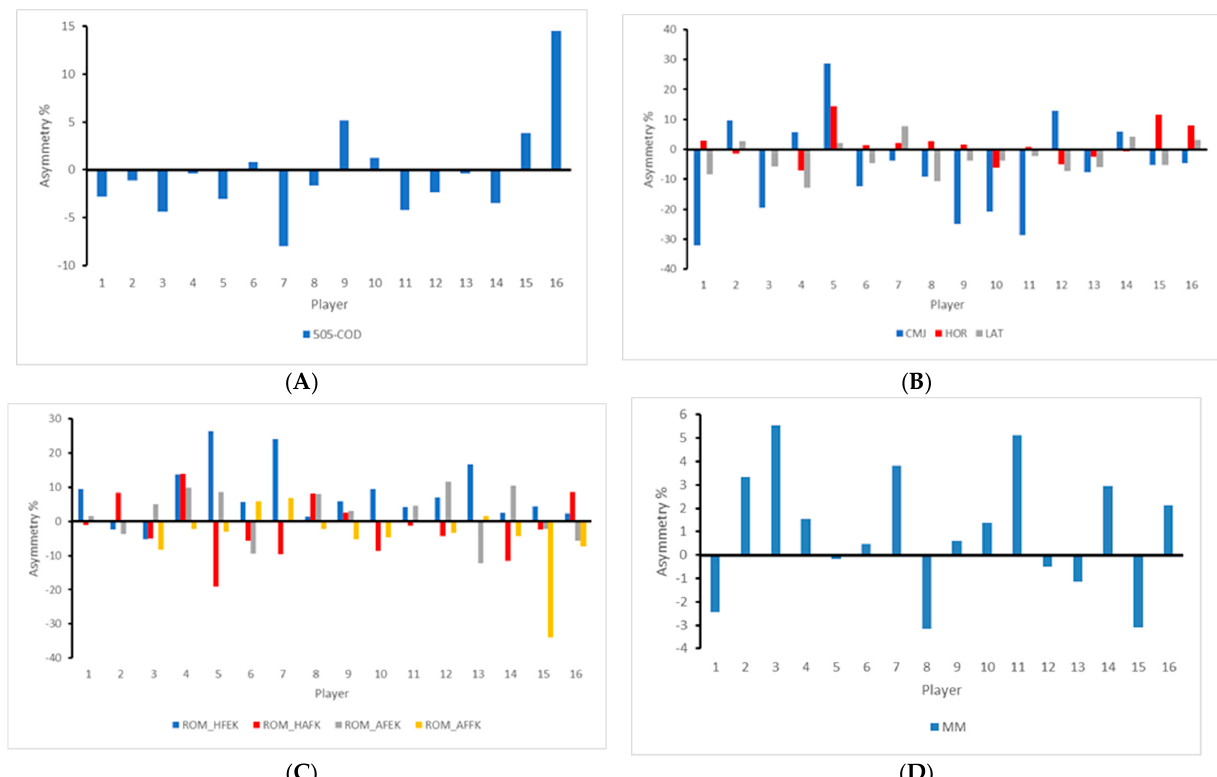
Figure 1. Individual asymmetry data for battery test (( A ) change of direction test; ( B ) jump test; ( C ) range of motion tests; ( D ) muscle mass). Above the line indicates raw score is greater on the right limb, and below the line indicates raw score is greater on the left limb. 505-COD: 505 change of direction test. CMJ: countermovement jump; SBJ: standing broad jump; LAT: lateral jump. ROM: range of motion; HFEK: hip flexion with extended knee; HAFK: hip abduction with flexed knee; AFEK: ankle flexion with extended knee; AFFK: ankle flexion with flexed knee. MM: muscle